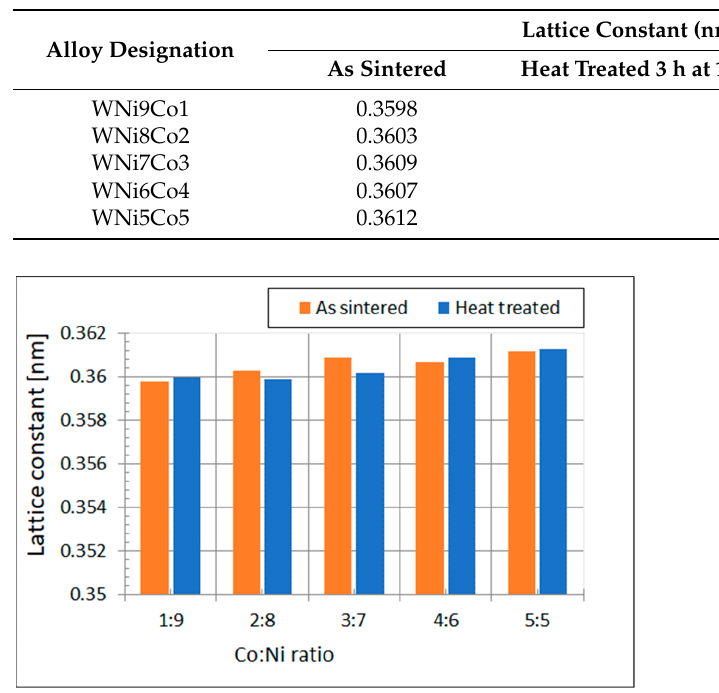
Table 6. The results of the calculated lattice parameter of the Ni base matrix.